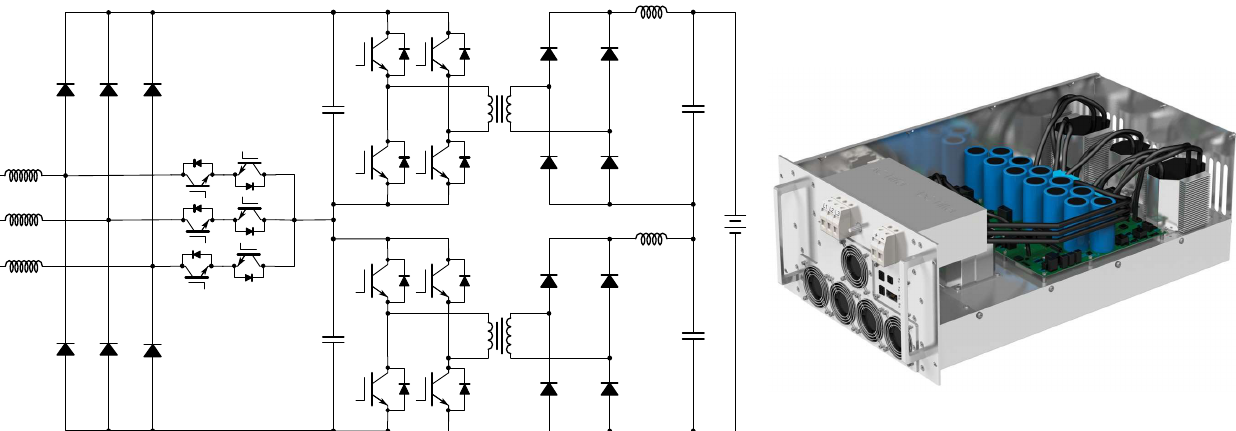
Figure 9. Modular 50 kW power cell (Designed by Semikron).